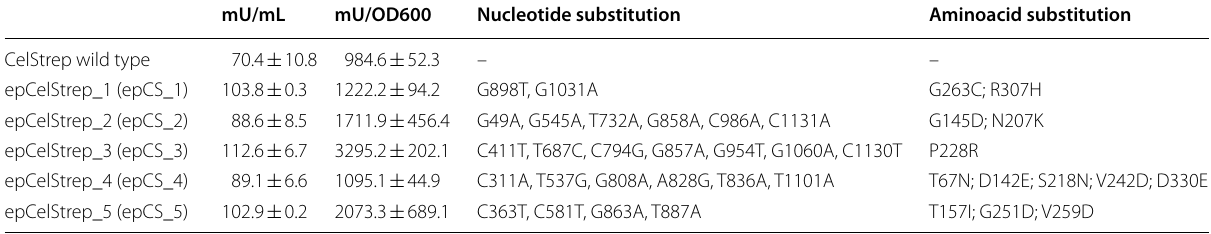
AZO-CMCase activity levels of the CelStrep wild type and of the five evolved enzymes expressed as mU/mL and normalized to OD 600nm . The enzymes were assessed for the endoglucanase activity in liquid medium in the presence of 1% CMC at 50 °C. Experiments were performed in triplicate. Nucleotide and aminoacid substitutions in the selected rCelStrep variants